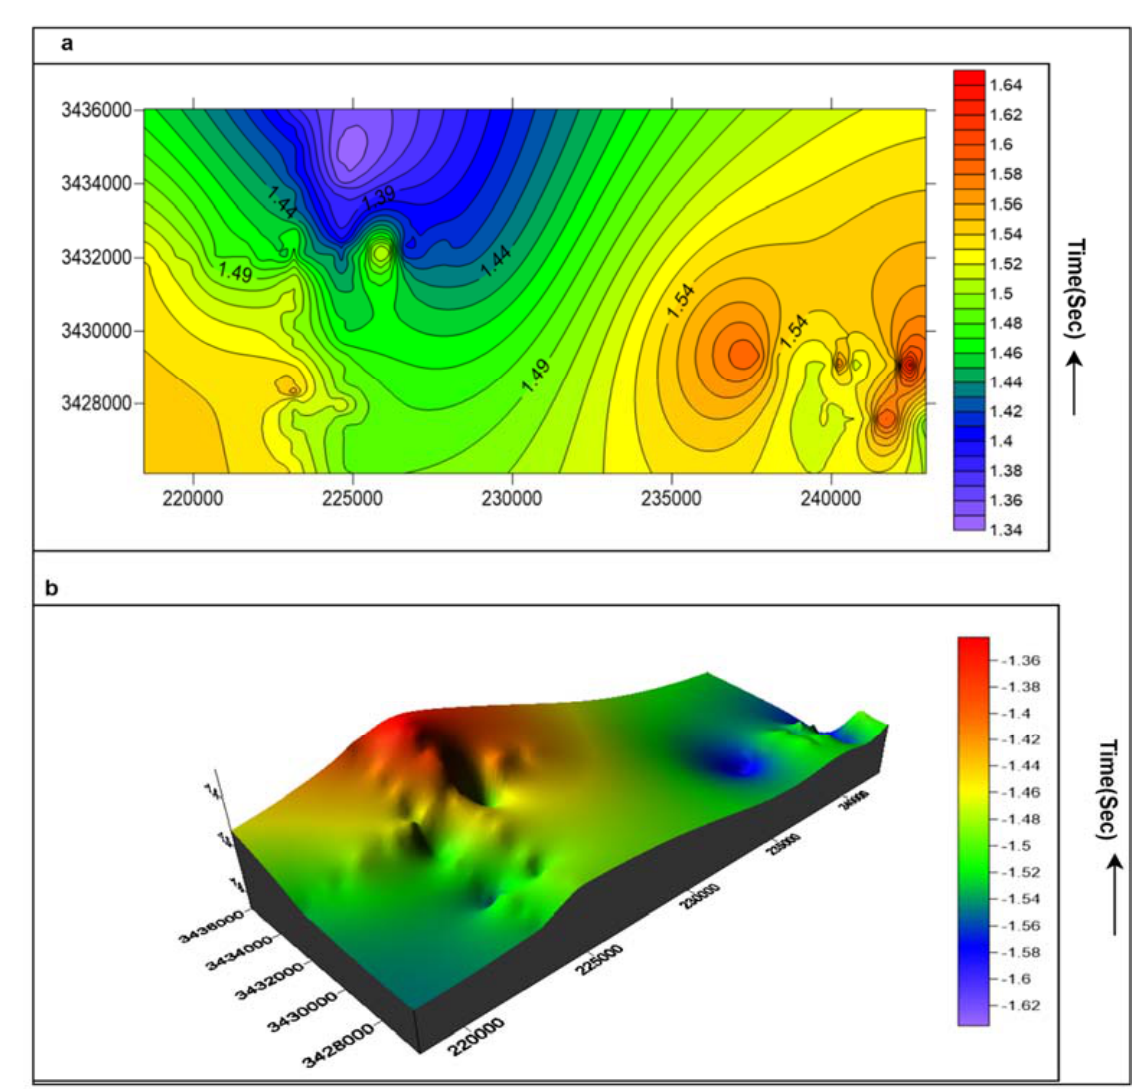
Figure 11 . ( a ) Time contour map of the Warcha formation. ( b ) Time surface map of the Warcha formation.